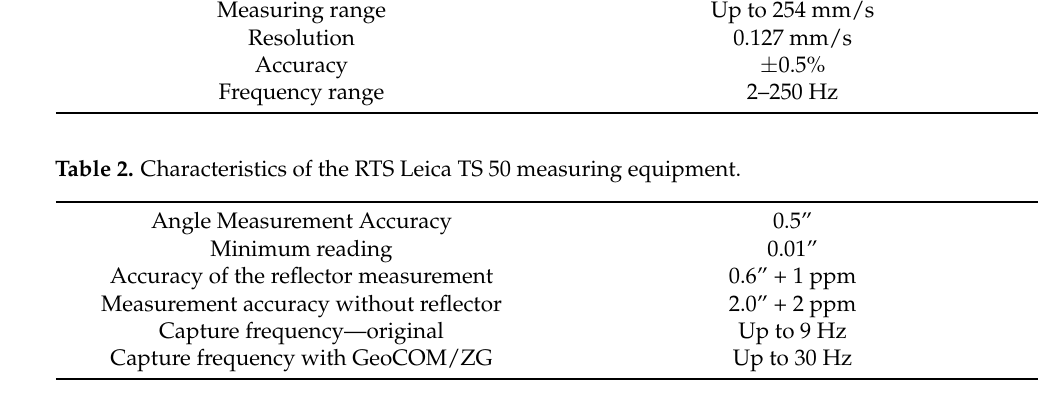
Figure 2. The sensors of the measuring equipment used, rigidly connected to the prestressed reinforced concrete railway sleeper with a glued threaded rod: (1) geophone, (2) geodetic prism, (3) Doppler radar beam measuring sheet glued to the geophone casing.